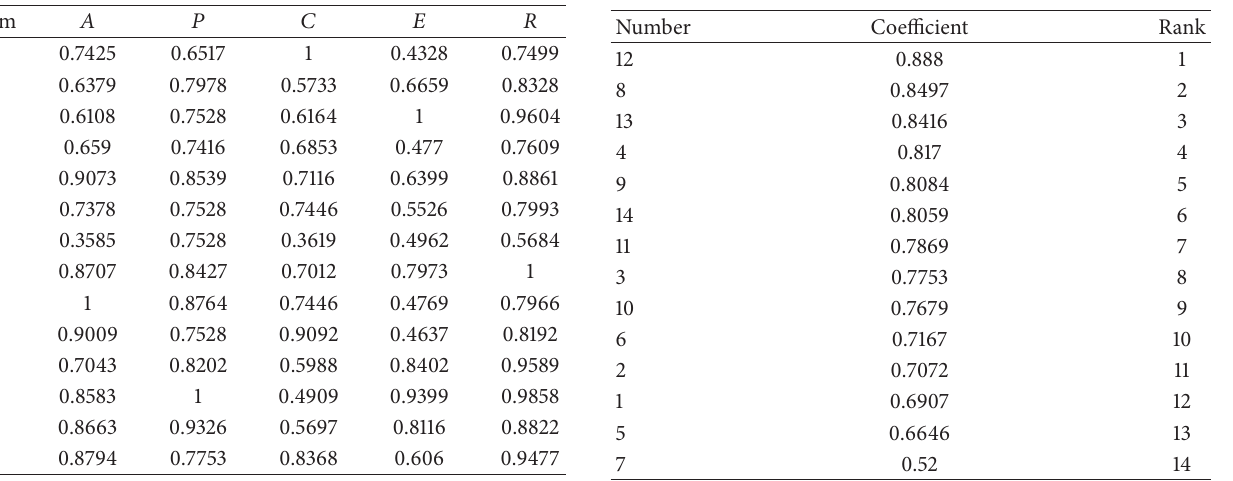
Table 4: Features normalized.